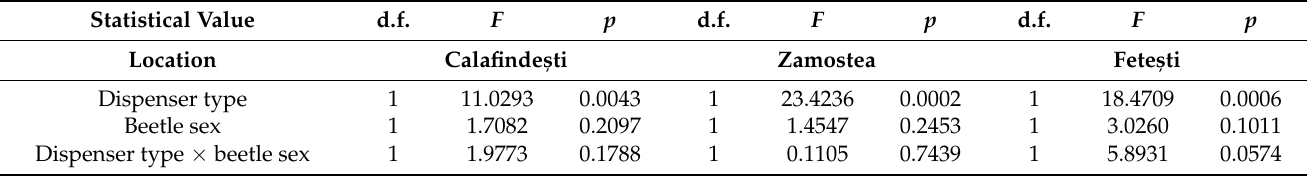
Figure 3. Comparison of the total Ips duplicatus captures obtained on the first field experiment for traps baited with ID Ecolure and ID RO dispenser types. Bars with different lowercase letters indicate significant differences according to (Tukey’s multiple comparison test: p < 0.05). Table 3. Results of statistical analysis of differences between Ips duplicatus captures depending on dispenser type and beetle sex (ANOVA test, p < 0.05).